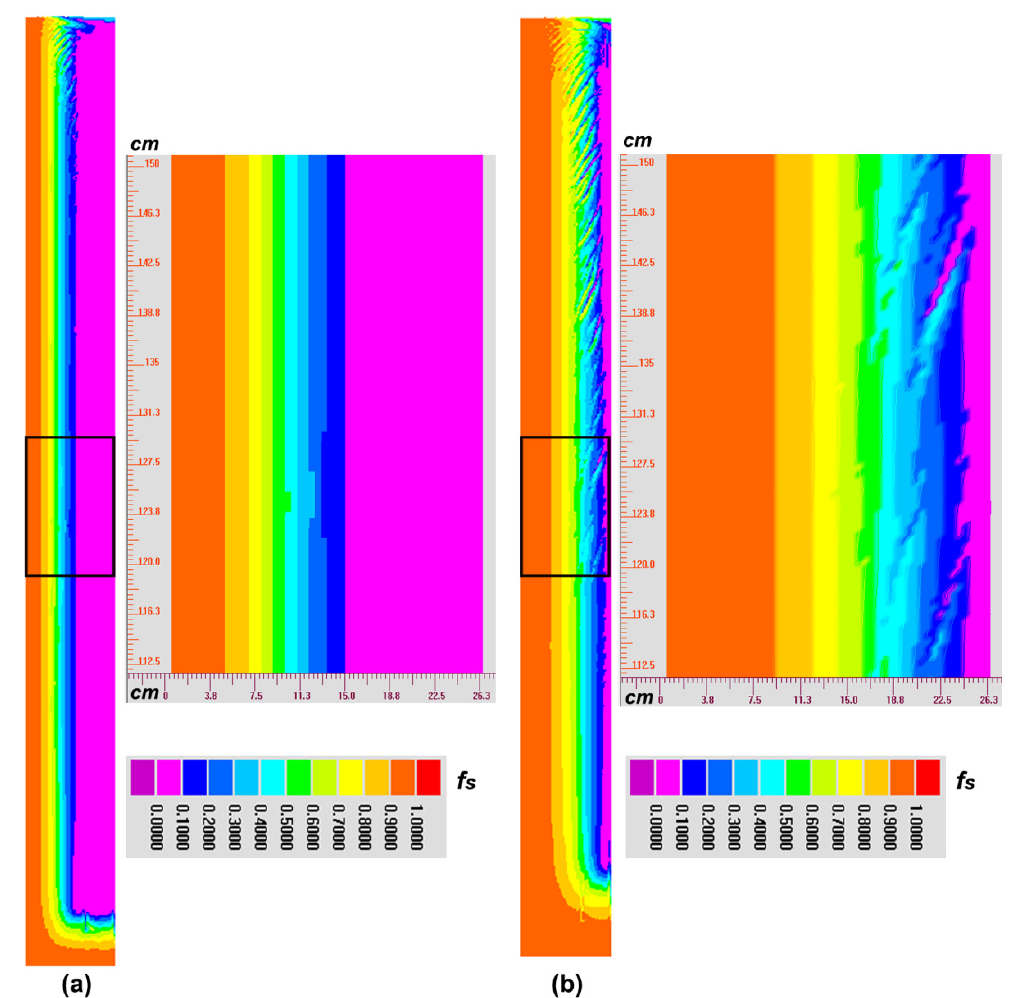
Figure 10. The distribution and evolution of isolines of solid fraction during the early ( a ) and middle ( b ) stages of solidification in the NbTi ingot. ( a ) 1000s; ( b ) 2700s. The enlarged views of solid fraction isolines in the black box are also attached, respectively.